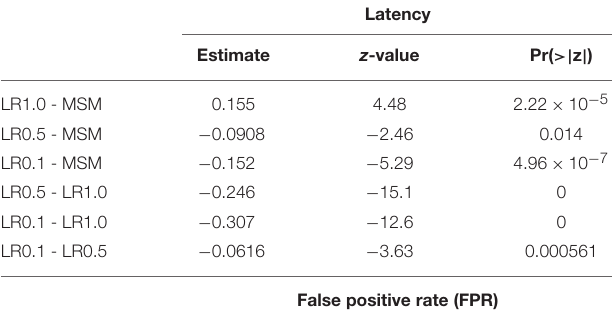
TABLE 2 | Result of multiple